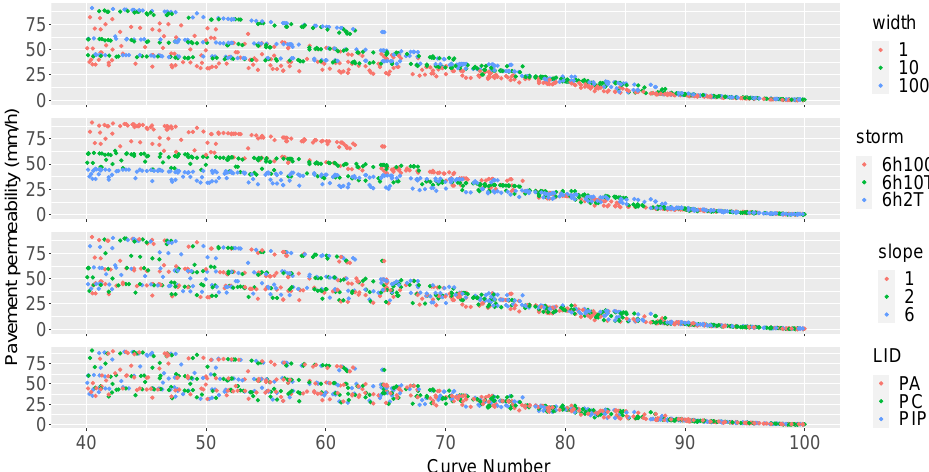
Figure 5. Pavement permeability values for fitted hydrographs with different colors for considered catchment shapes ( first row ), precipitation depth ( second row ), pavement slope ( third row ), and LID layout ( fourth row